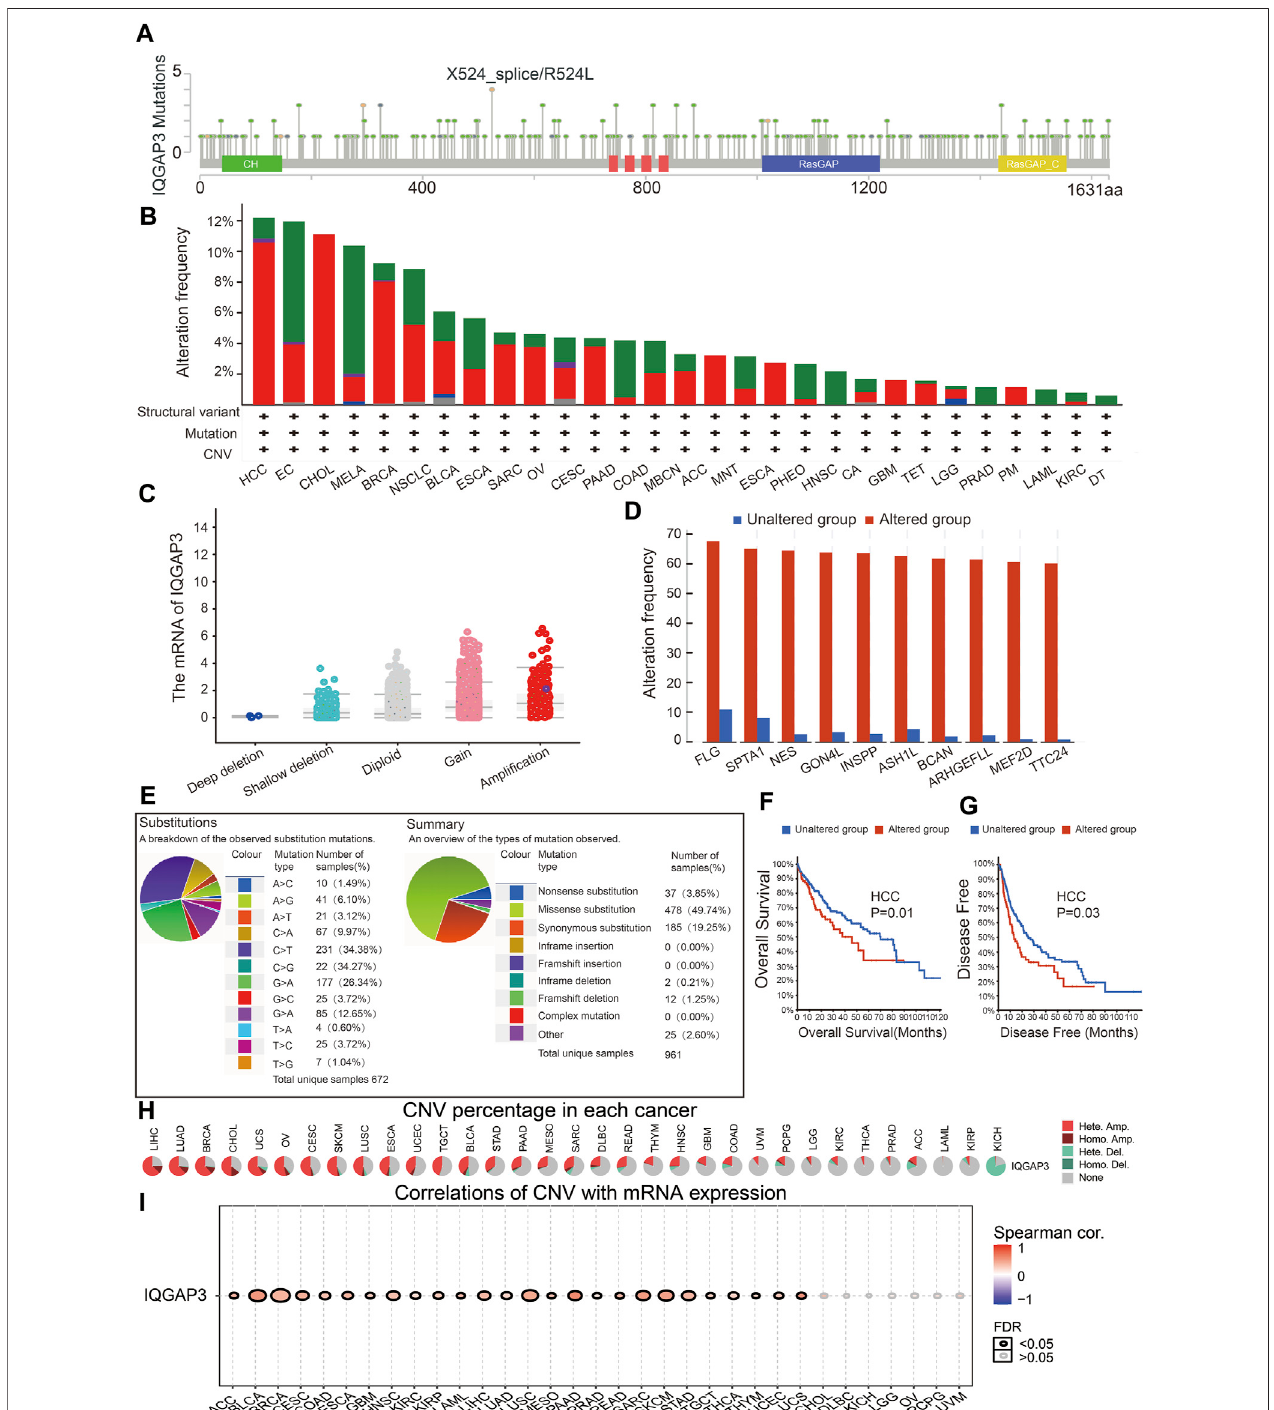
FIGURE 6 | Analysis of the gene mutation of IQGAP3 in pan-cancer. (A) Representation of IQGAP3 mutations (TCGA) in diverse human cancers by using the cBioPortal database. (B) The mutation frequency of IQGAP3 in pan-cancer was examined by employing the cBioPortal database; red: ampli fi cation, green: mutation, blue: deep deletion, and purple: structural variant. (C) The correlation between the gene mutation of IQGAP3 and its expression in pan-cancer was examined by employingthecBioPortaldatabase. (D) ThecorrelationbetweenthegenemutationofIQGAP3andtheclosestgeneinpan-cancerwasexaminedbyemployingthe CIO portal database. (E) The percentages of mutation types of IQGAP3 in pan-cancer were indicated in a pie chart examined by employing the Catalogue of Somatic Mutations. (F) The mutation ofIQGAP3 affects theOSof HCC patients examined byemploying thecBioPortal database. (G) The mutation ofIQGAP3 affectstheDFS of HCC patients examined by employing the cBioPortal database. (H) The CNV of IQGAP3 in diverse human cancer by using the GSCA database. (I) The correlation between the CNV of IQGAP3 and its expression in pan-cancer was examined by using the GSCA database.